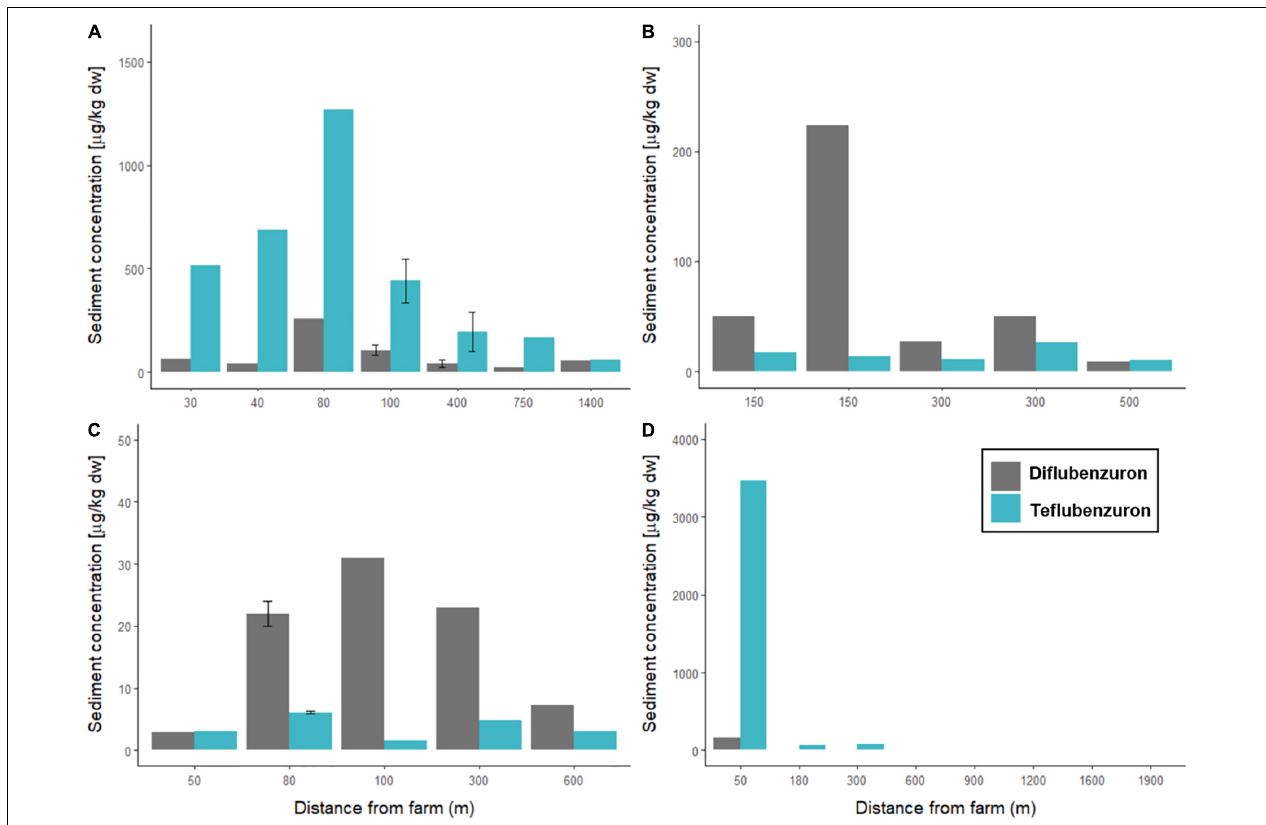
FIGURE 3 | Concentrations of anti-sea lice insecticides measured in marine sediments sampled around four Norwegian fish farms. Diflubenzuron (grey) and teflubenzuron (light blue) levels ( µ g/kg dw) are shown for sediments sampled at varying distances (m) from (A) Farm A, (B) Farm B, (C) Farm C, and (D) Farm